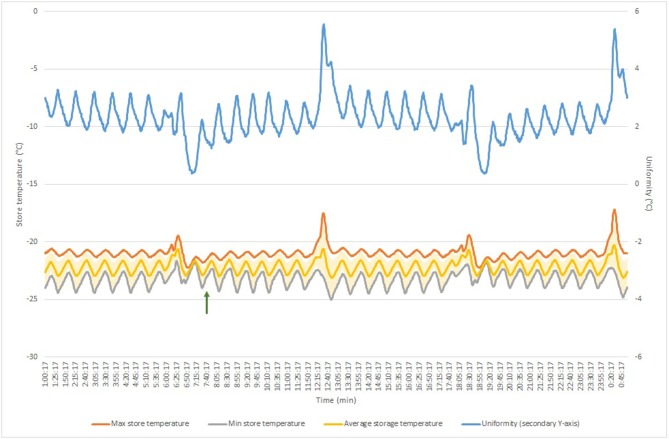
Temperature homogeneity measurement in Sample Store over 24 h measurement period. Green arrows indicate door opening session start. Blue line shows temperature uniformity (displayed on secondary axis); yellow line displays average store temperature (with standard deviation indicated in light-yellow error bars); orange line shows maximum store temperature; gray line shows minimum store temperature.